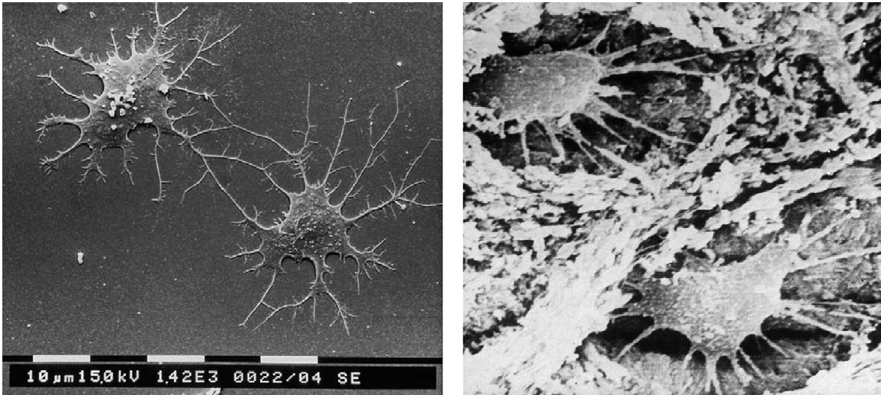
Figure 5: Osteocytes are linked together in a network via numerous cellular processes: these images show examples of cells with and without the surrounding bone matrix [7].